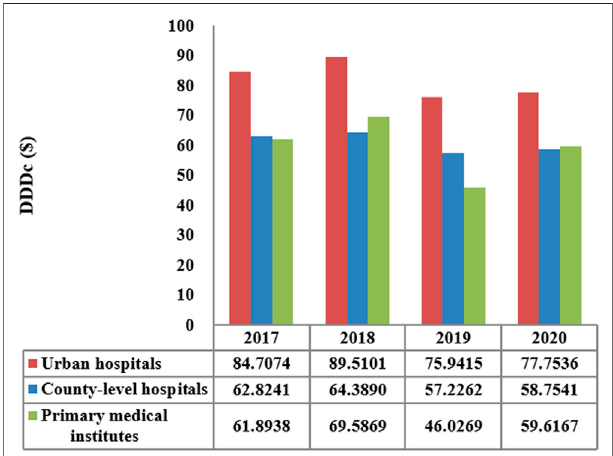
FIGURE3| DDDcofcarbapenemsbythelevelofhealthcareinstitutionin Shaanxi Province, 2017 – 2020.